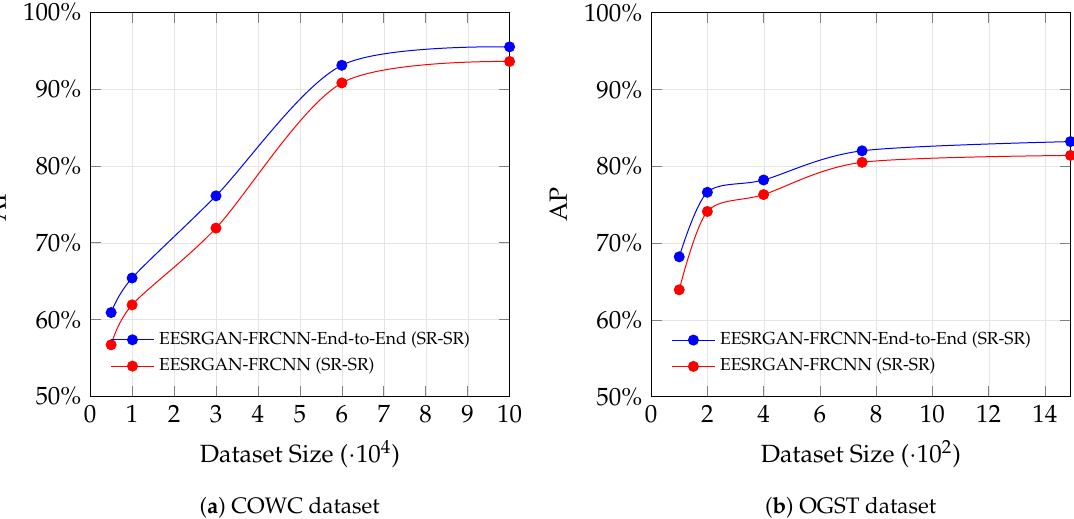
Figure 10. AP (average precision) with varying number of training sets from the datasets. Plotted results show the detection performance of our proposed method (with and without end-to-end training) on SR (super-resolution)